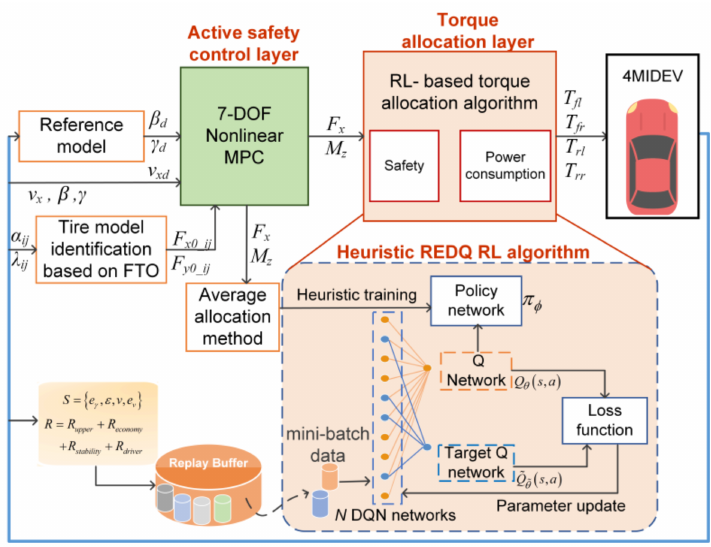
Figure 1. The block diagrams of the TVC